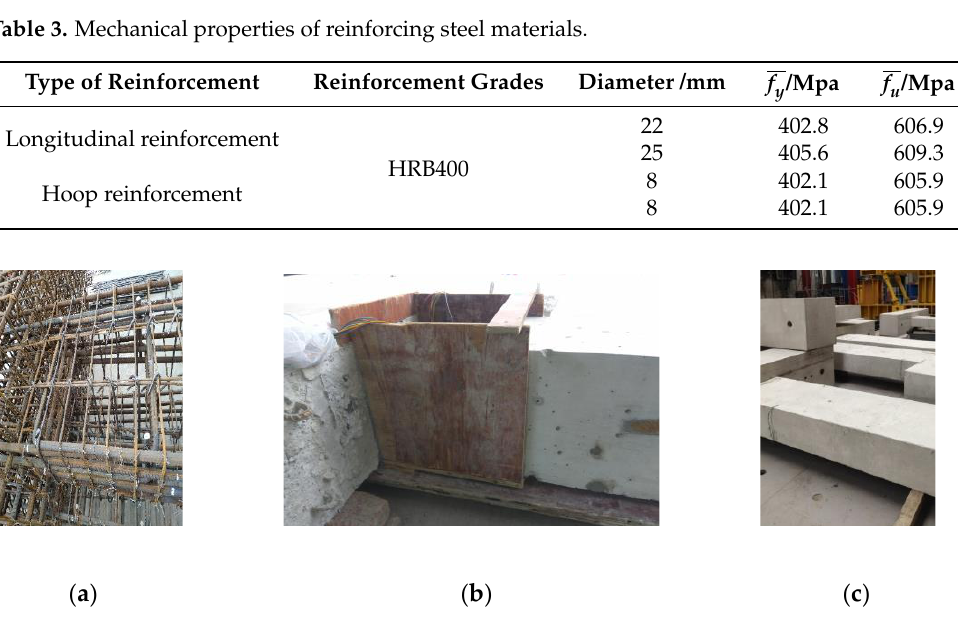
Table 2. Mechanical properties of concrete materials.